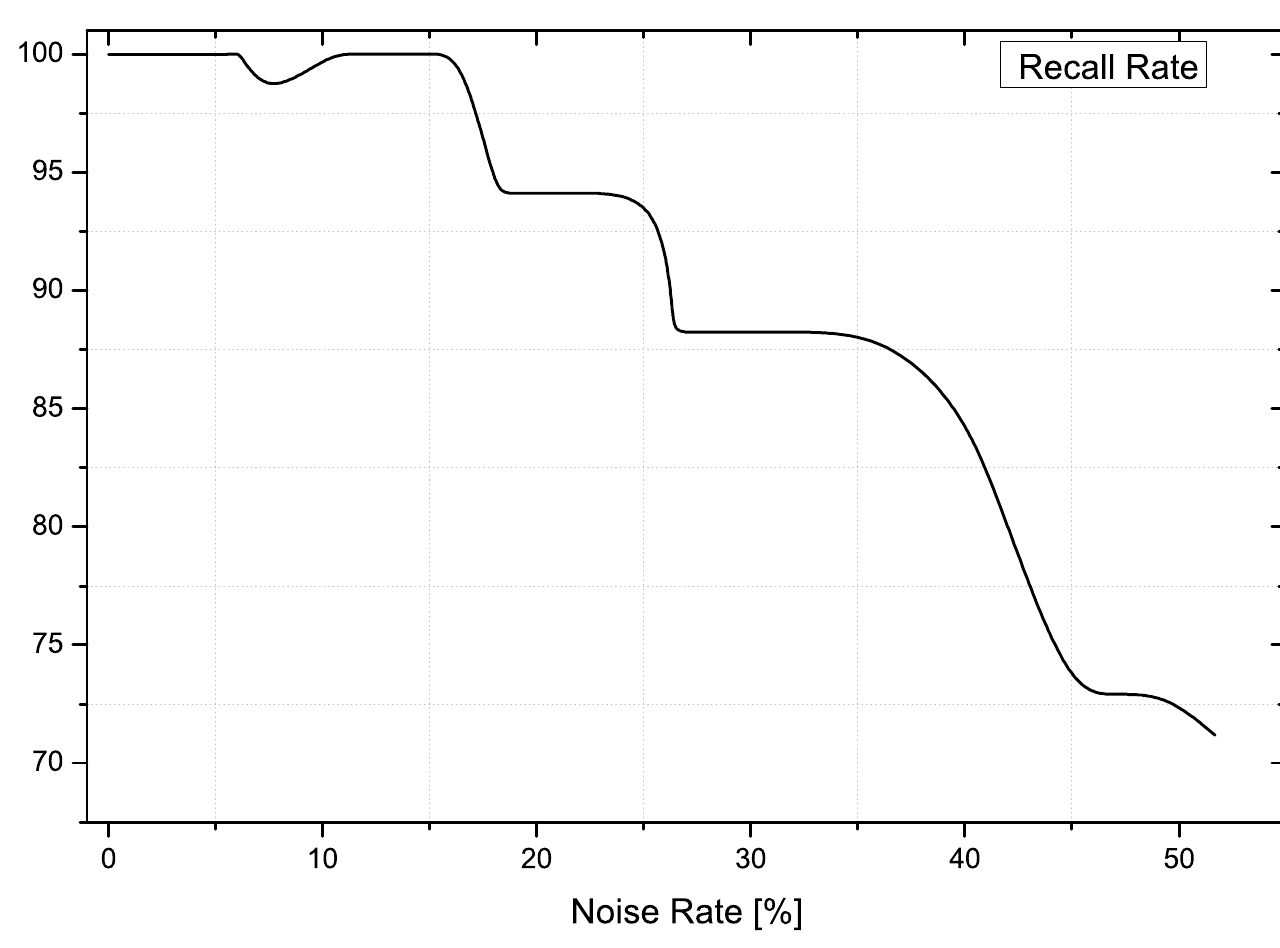
Fig 15. Effect of noise on the recall rate.